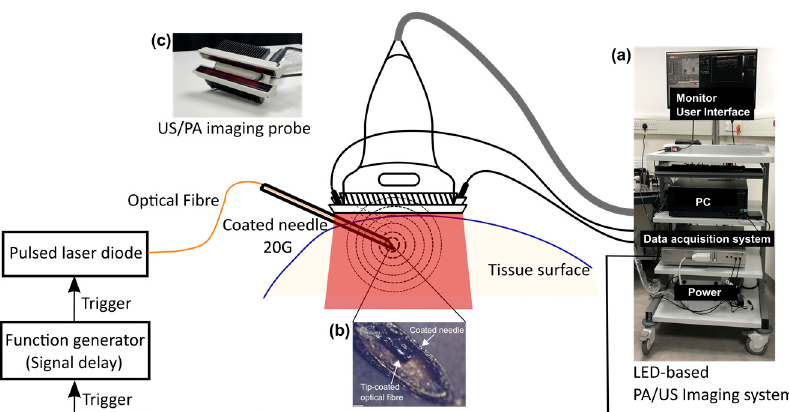
Figure 1. Schematic diagram of the dual-modal photoacoustic (PA) and ultrasound (US) imaging system combining extracorporeal and interstitial illumination with elastomeric nanocomposite coatings for needle enhancement. ( a ) LED-based PA/US imaging system on a trolley; ( b ) Photograph of the needle tip showing a tip-coated fibre inside the lumen providing interstitial illumination for needle tip visualization (scale bar: 200 μm ); ( c ) Photograph of the PA/US imaging probe with LED bars providing extracorporeal illumination for needle shaft visualisation.